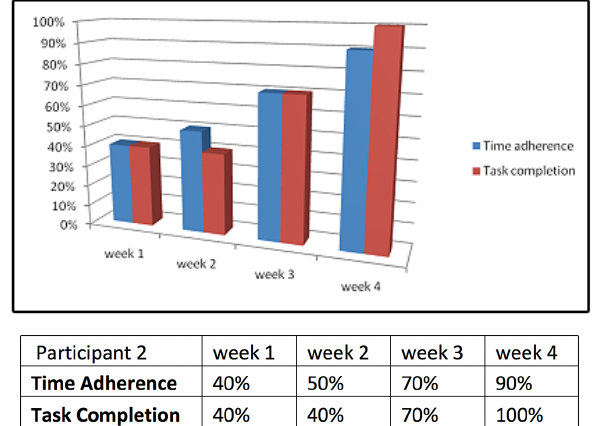
Figure 2. Time adherence and task completion: Performance of Participant 2 over four